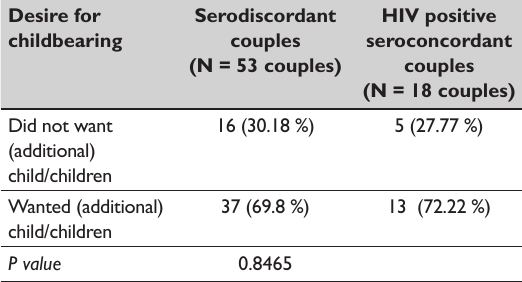
Table 3: Desire to procreate in serodiscordant and HIV positive seroconcordant couples Desire for Serodiscordant childbearing